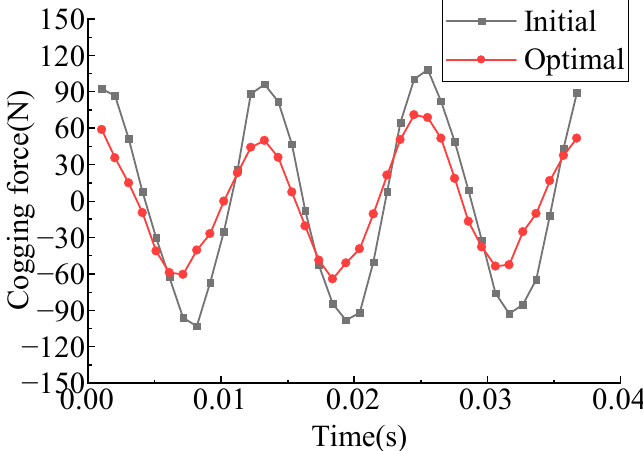
Figure 6. The waveform of cogging force.